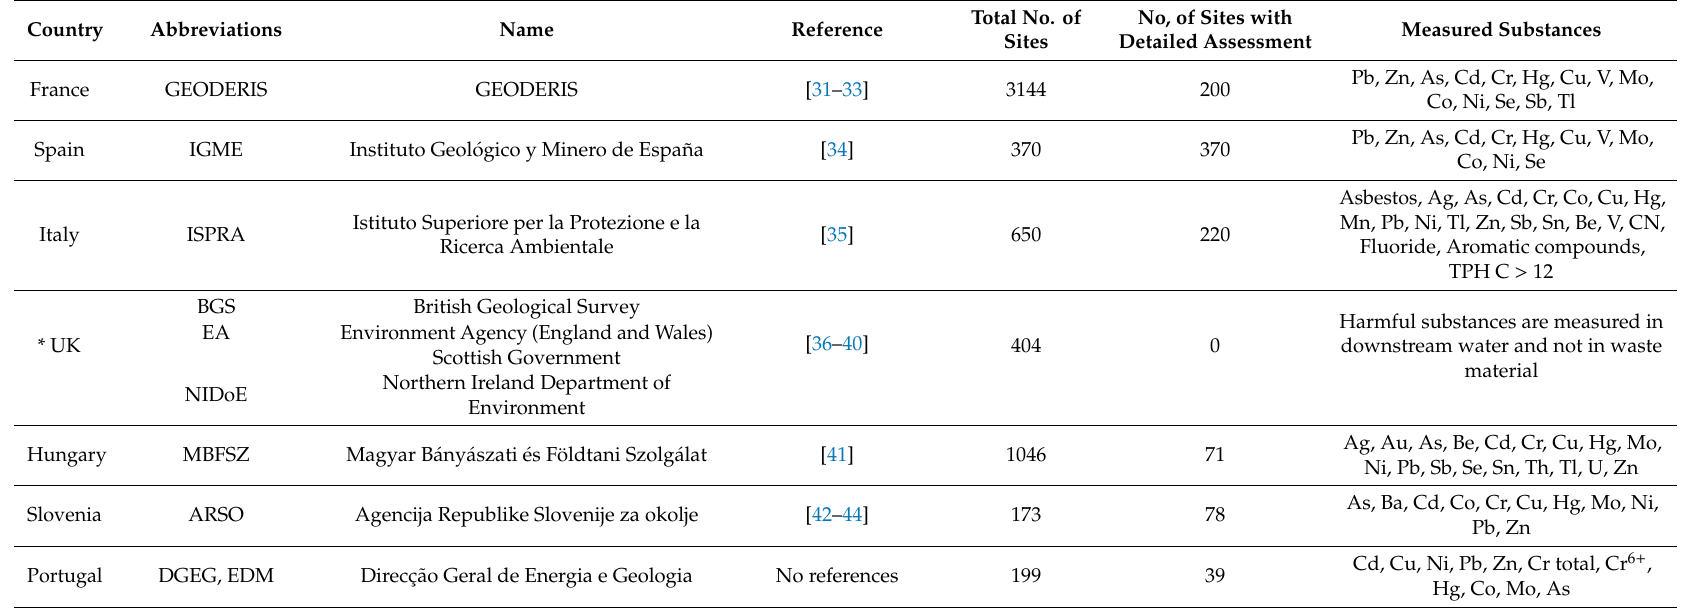
Table 1. Responsible organisation for preparing and keeping the National mine waste registries and basic information about the registries.